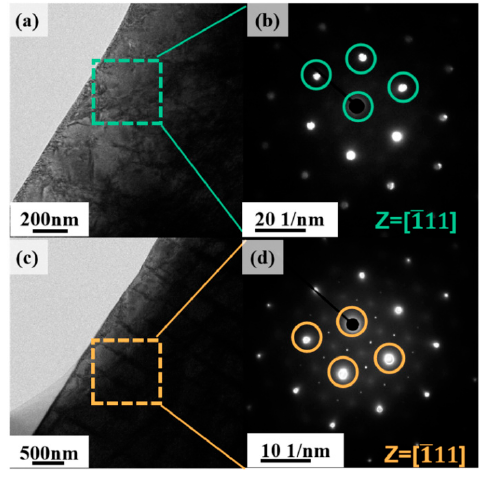
Figure 3. Selected area electron diffraction patterns of ( a , b ) the recast layer and ( c , d ) the matrix. The recast layer has a single-crystal structure with the same orientation in